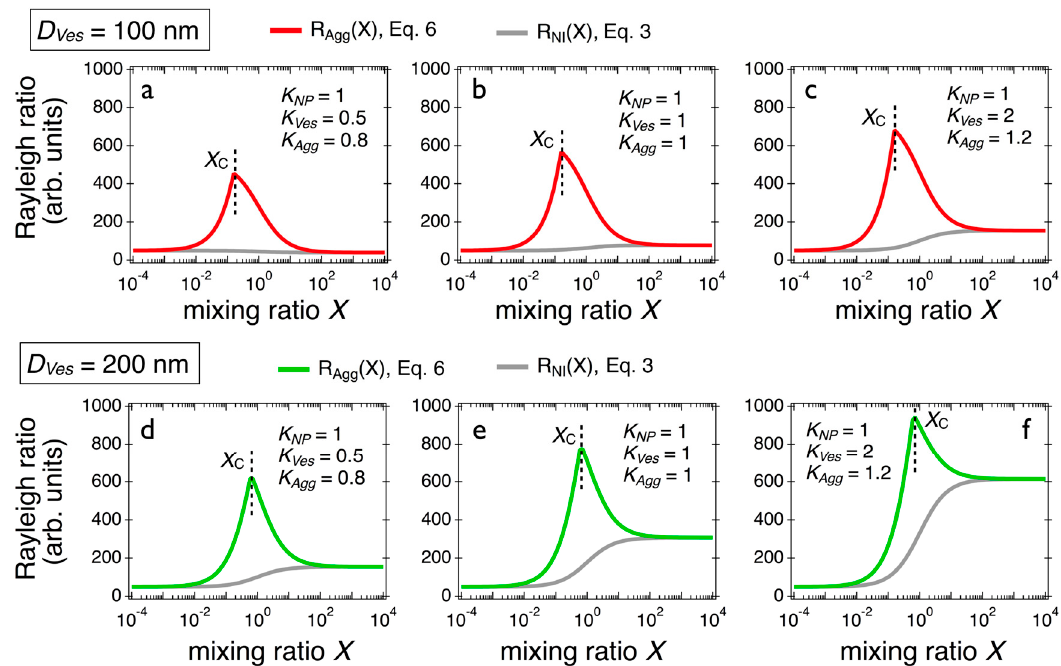
Figure 2. ( a – c ) Scattering intensity obtained for mixed solutions containing 40 nm silica nanoparticles and 100 nm lipid vesicles, in the case of aggregate formation, using three different sets of contrasts, ( K NP , K Ves , K Agg ) = (1, 0.5, 0.8), (1, 1, 1), and (1, 2, 1.2), respectively. The curves in red refer to ( m = 10, n = 1)-aggregates (Equation (6)), whereas those in grey arise from non-interacting species (Equation (3)). The m and n denote the number of particles and vesicles in the aggregates, respectively. ( d – f ) Scattering intensity obtained for mixed solutions containing 40 nm silica nanoparticles and 200 nm lipid vesicles, with the same set of contrasts as above.